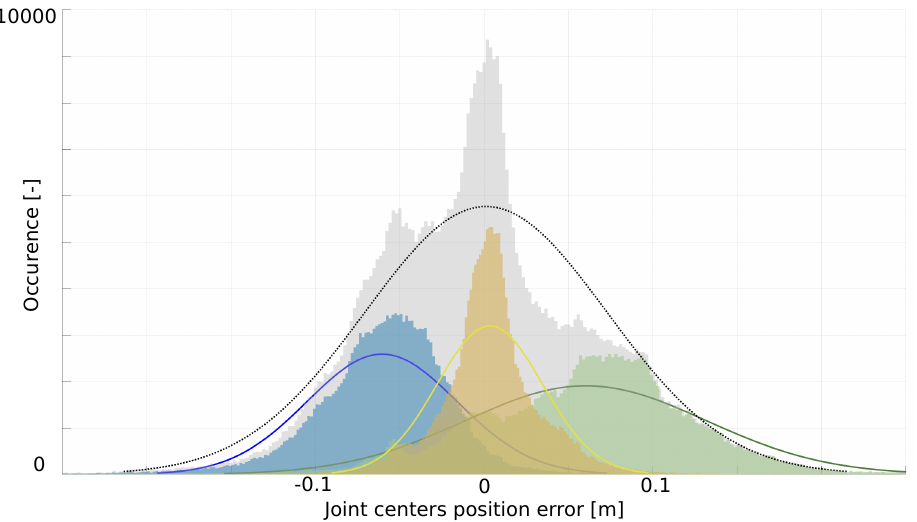
Figure 3. Distribution of the difference between joint position centers estimated from the SS and from the K2S obtained for all recorded data along the x (blue), y (green) and z (yellow) axes. The grey distribution indicates the average